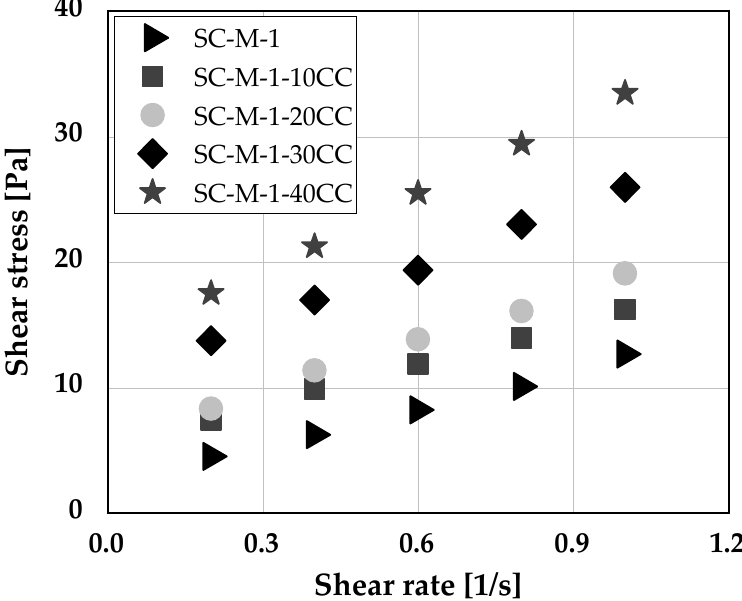
Figure 6. Shear stress of SC-M with varying V cc , at constant V w /V p = 0.875 and SP dosage of 0.50. The adjustment of SP dosage is urgently required to control the degree of deformity of SC-M with increasing the volume of CC as cement replacement. Figure 7 shows the influence of increasing SP dosage on dynamic yield stress and plastic viscosity of SC-M produced with a varying volume of CC. A higher SP dosage decreased both the yield stress and plastic viscosity of the mortar with and without CC. This decrease was more pronounced in the control mixture, resulting in a higher tendency of segregation, as ob- served also in Figure 5. For instance, about 0.5 wt.% SP dosage was required to deform the control mixture and to reduce the dynamic yield stress from 10.6 Pa to 3.1 Pa, while the corresponding plastic viscosity dropped from 20 Pa · s to 12 Pa · s. For the SC-M with CC replacement at 20 and 40 vol.%, the required dosage of SP increased to 0.55 and 0.60 wt.% SP in order to achieve the same degree of deformability, respectively. The corresponding plastic viscosities, however, remained at 19 and 22 Pa · s, respectively. At 40 vol.%